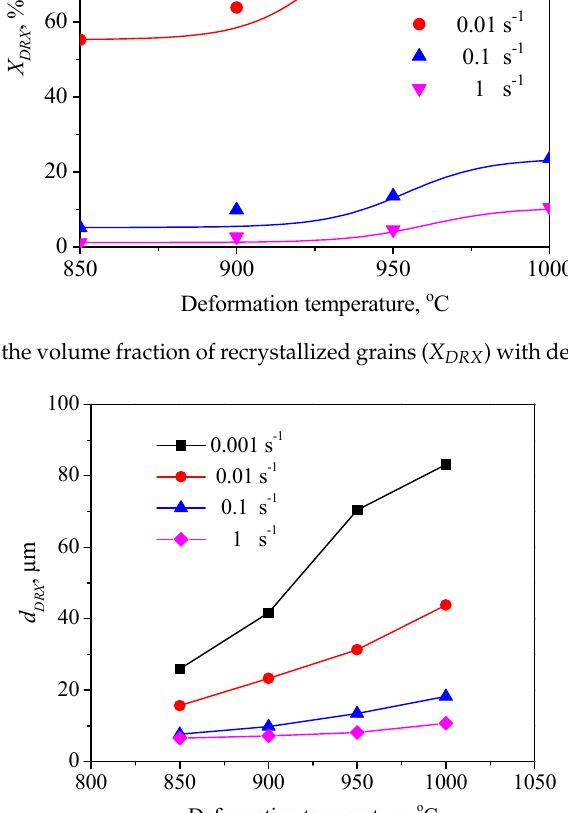
Figure 5. The grain size of recrystallized grains ( d DRX ) as a function of deformation